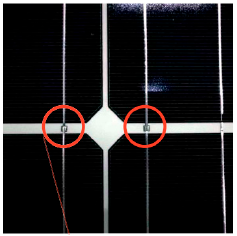
Figure 8. BP diodes place on each cell [114].